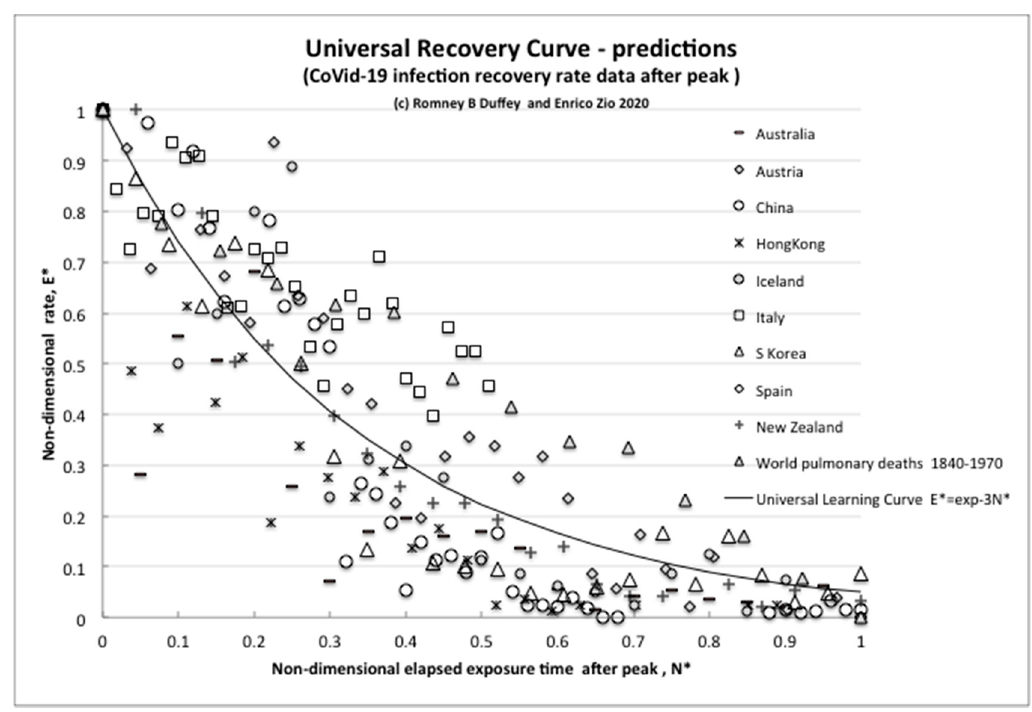
Figure 2. The universal recovery curve.